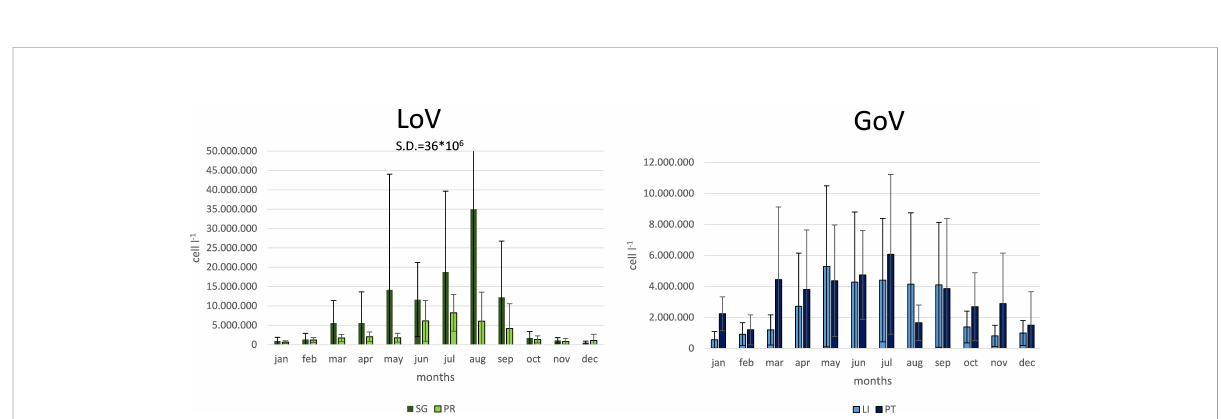
FIGURE 6 Monthly averages and standard deviations of phytoplankton abundance at the four stations in the LoV (St. SG and St. PR; left) and GoV (St. LI and St. PT; right). SG, San Giuliano station; PR, Palude della Rosa station; LI, Lido station; PT, Platform